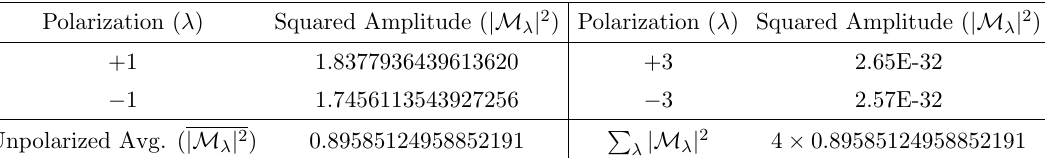
Table 6. For the gravitino scattering process g rv ( p 1 ; (cid:21) ) + g rv ( p 2 ) ! (cid:28) + ( p 3 ) + (cid:28) (cid:0) ( p 4 ), the squared scattering amplitude jMj 2 as a function of gravitino helicity (cid:21) , de(cid:12)ned in the partonic c.m. frame at the phase space point provided in the text, as well as the unpolarized, spin-averaged squared matrix element jMj 2 , and the sum of the four squared